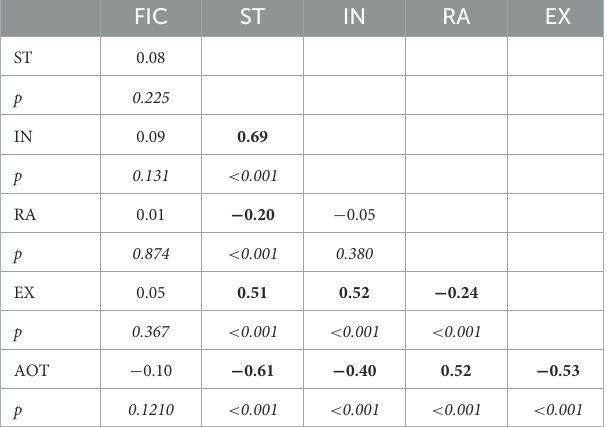
TABLE 7 Experiment 2: Generalized linear mixed models, Interactions: rational and experiential thinking-style. Rational